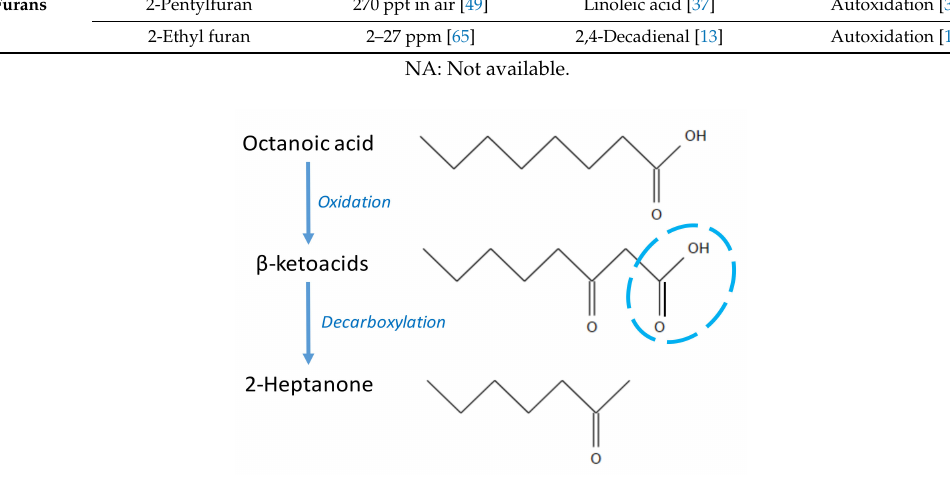
Figure 2. The formation of heptanone through the lipolysis pathway as an example of methyl ketone formation from β -oxidation and decarboxylation of fatty